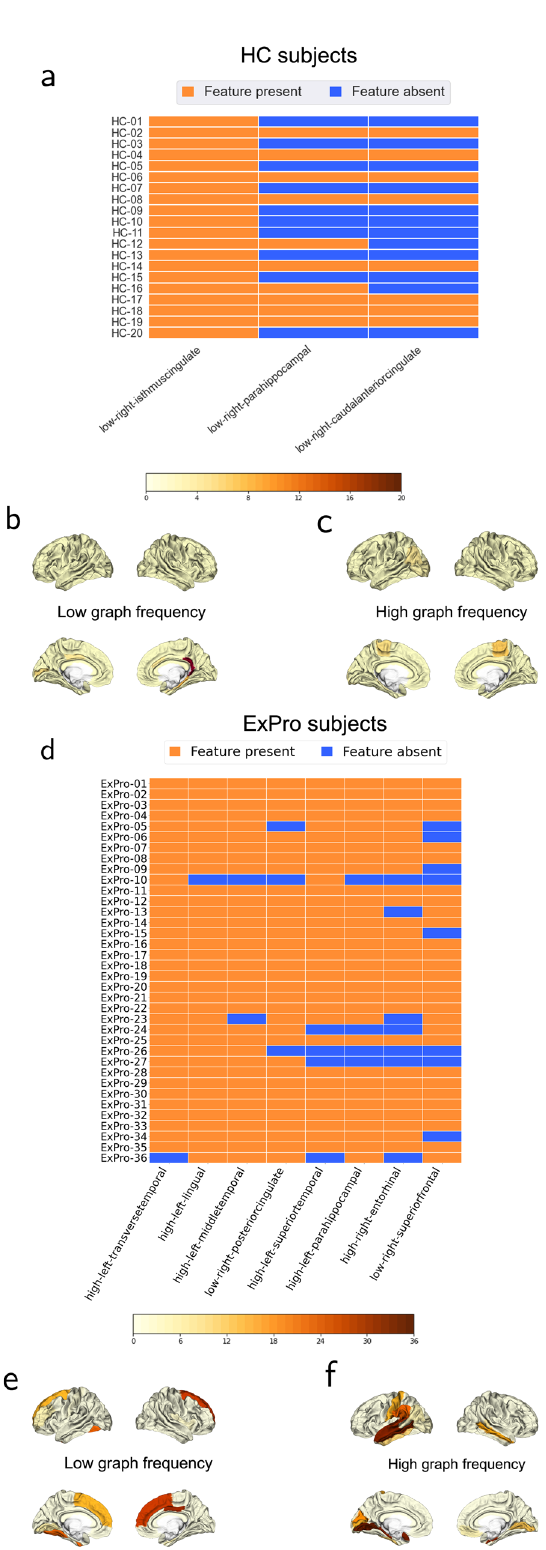
Fig. 3 Robustness of GSP features as predictors. a , d show the carpet plots illustrating the presence of GSP features in the best performing model in the leave-one-out cross validation process for predicting serum NfL for every subject when it was excluded from the training of model. Each row